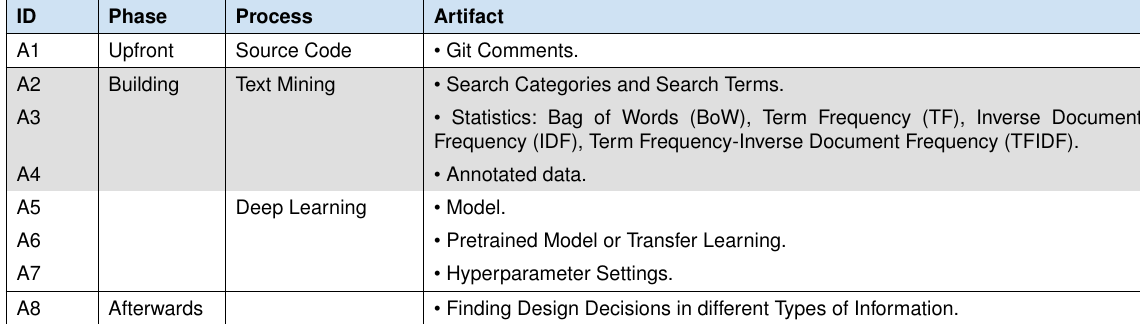
Table 3. Candidate Artifacts in Automated Text